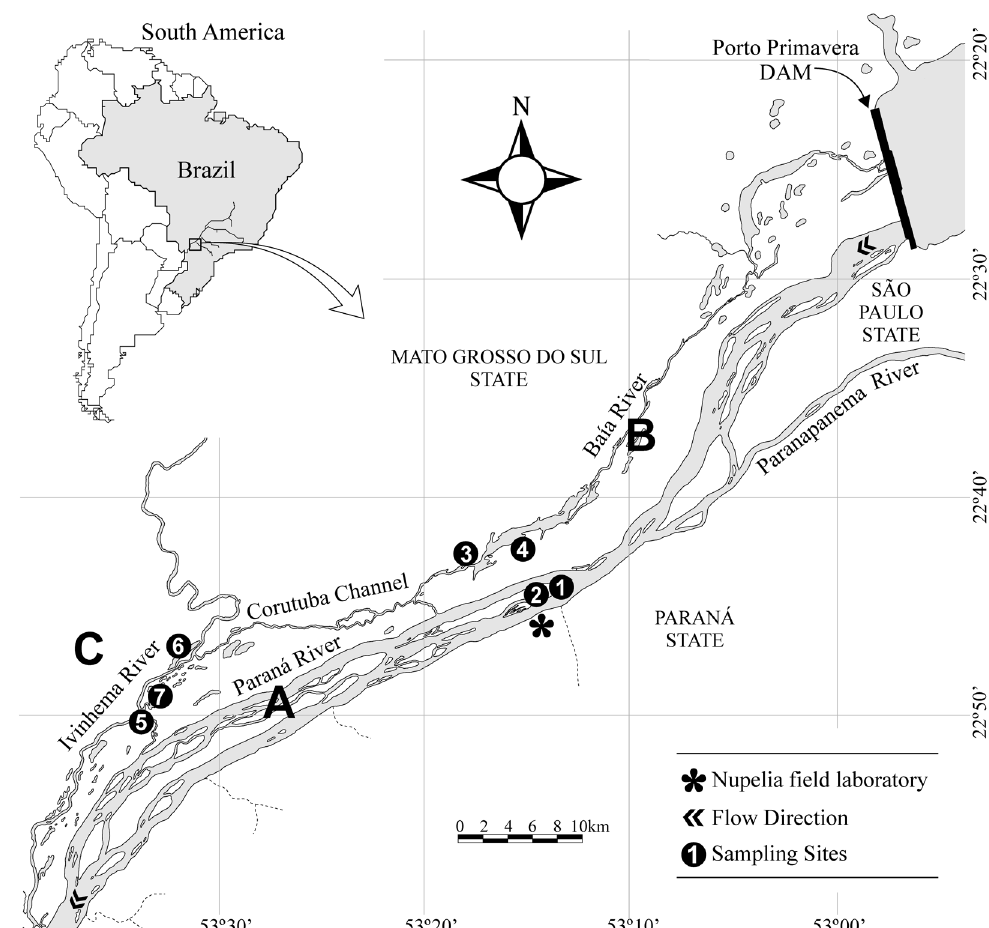
Fig. 1. Map of the floodplain of the Upper Paraná River, highlighting the areas sampled in this study. The subsystems sampled were A = Paraná River, B = Baía River and C = Ivinheima River. The numbers indicate sampled sites in each subsystem.